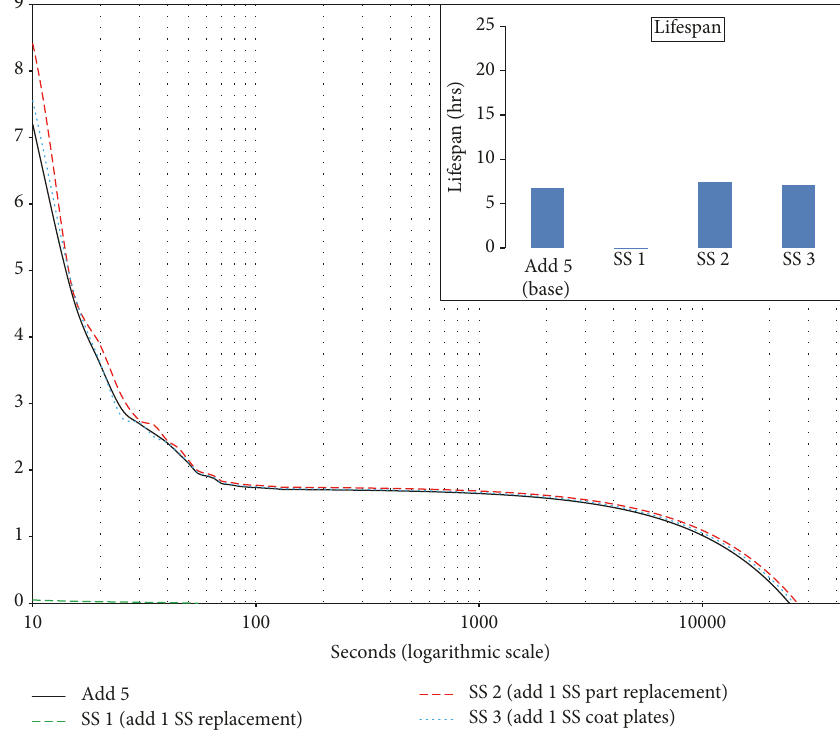
Figure 11: Current discharge curves across a 10 Ω resistor for sodium silicate